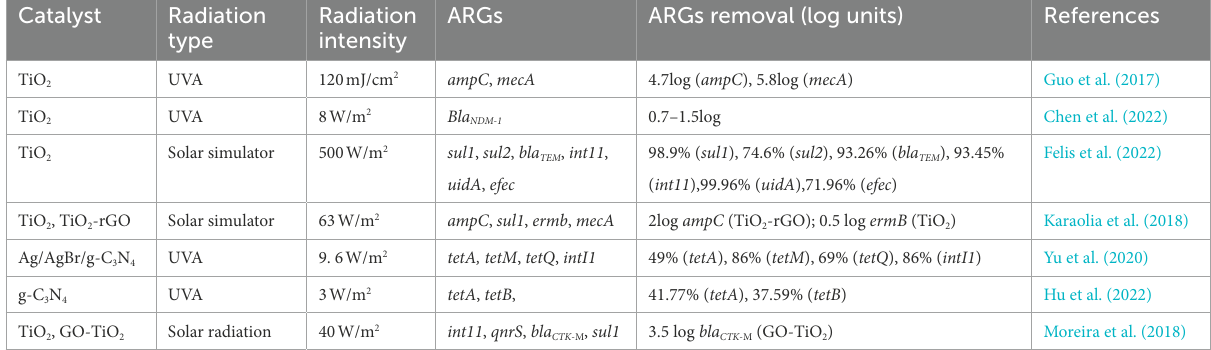
TABLE 3 Effect of different catalysts, radiation type and radiation intensity on the removal effectivness of ARGs.